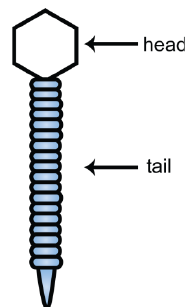
Figure 1. A cartoon representation of λ